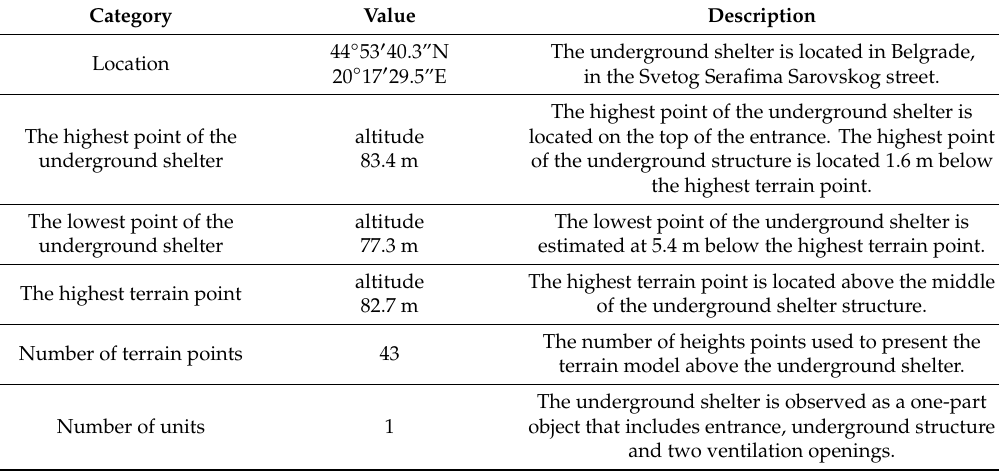
Figure 7. Study underground shelter. Table 3. Description of the case study underground shelter.